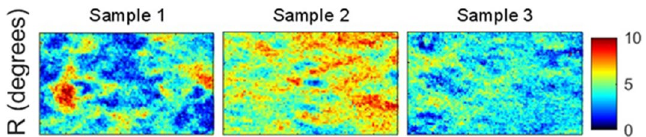
Figure 6. Retardance map for the analyzed areas of three C + SMC + EC